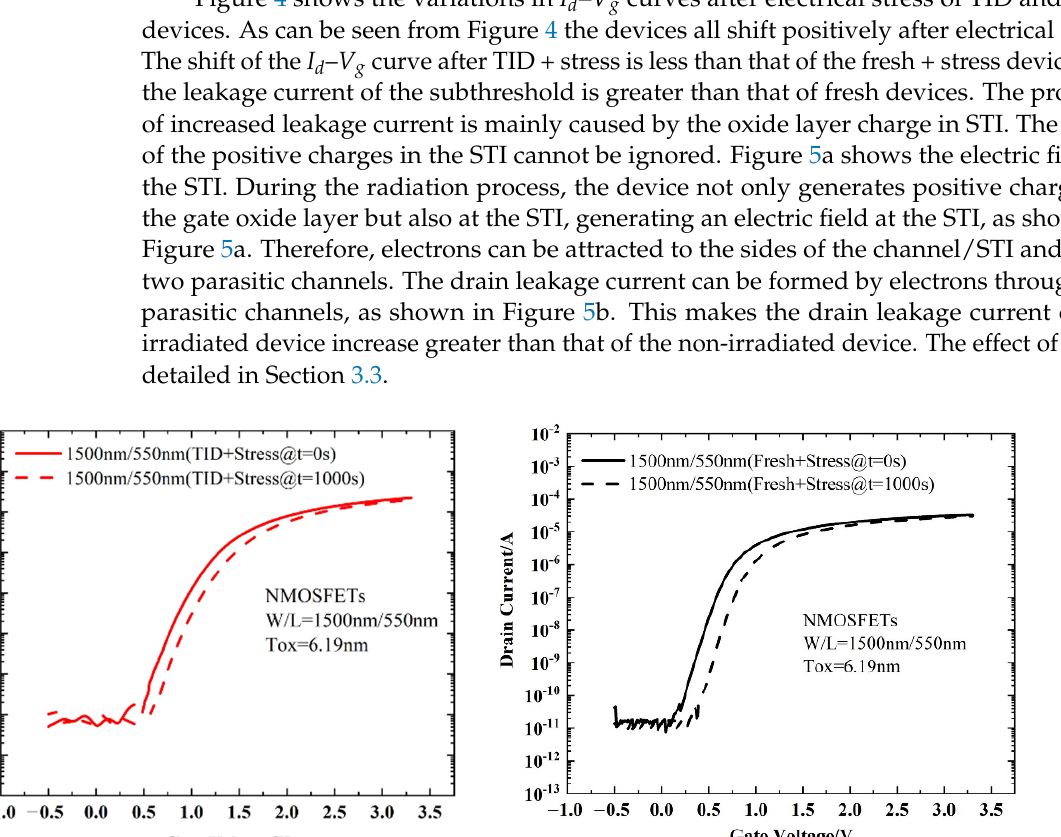
( b ) Figure 5. ( a ) Schematic diagram of STI electric field. ( b ) Schematic diagram of the parasitic channels generated by radiation in STI. Under stress conditions, the threshold voltage is one of the most important degrada ‐ tion parameters. The threshold voltages are obtained from the transfer curves. It can be seen from Figure 6a that the threshold voltage degradation of the device which is applied a gate voltage stress after irradiation is smaller compared to that with a gate voltage ap ‐ plied directly. As can be seen in Figure 6b, in the double logarithmic coordinates, the threshold voltage shift shows a linear relationship to the stress time. In other words, the shift of the threshold voltage caused by the gate voltage stress conforms to the law of power function, similar to the effect of bias temperature instability, and its degradation expression is:   lg  , (5) Thus, t   , (6) where α is the slope of the linear fit in double logarithmic coordinates, and b is the curve intercept. In a non ‐ irradiated device, the threshold voltage shifts by 0.2 V after 1000 s of stress; in an irradiated device, the threshold voltage shifts by 0.15 V after 1000 s of stress, which means that the radiation effect plays a role in weakening the degradation of the device during the biasing process. H will participate in both radiation and stress processes [20]. Unlike the reaction of H in the SiO 2 layer of traditional MOSFETs [21], in high ‐ K gate